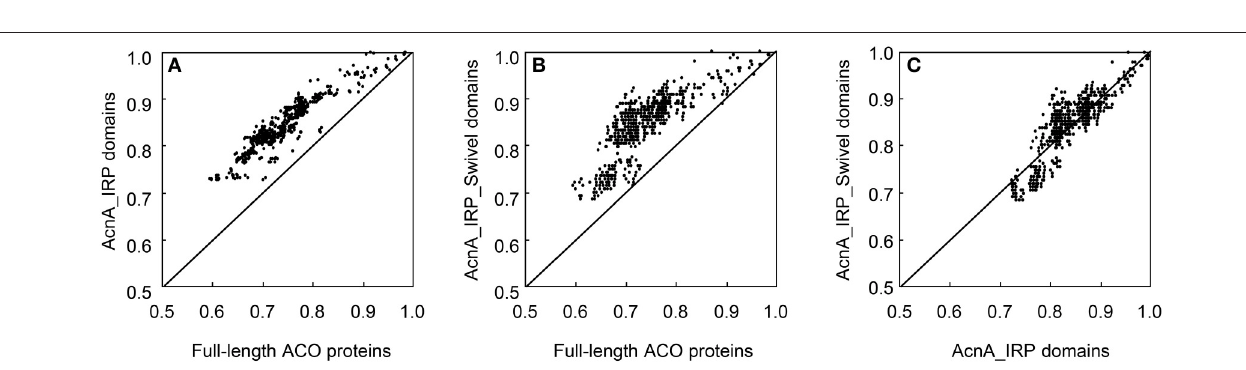
AcnA_IRP domain protein sequences of 36 ACOs